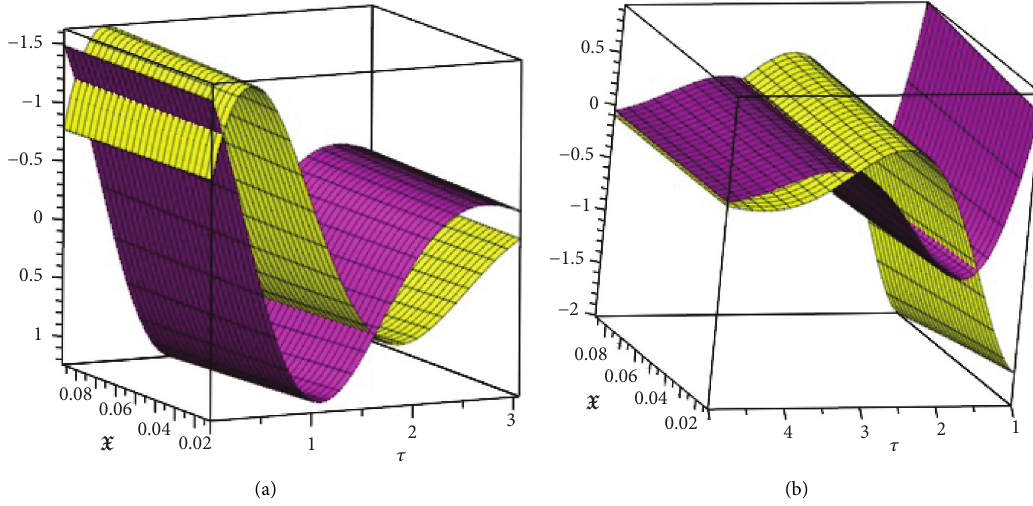
Figure 3: 3D with the imaginary and the real part of solutions Ψ